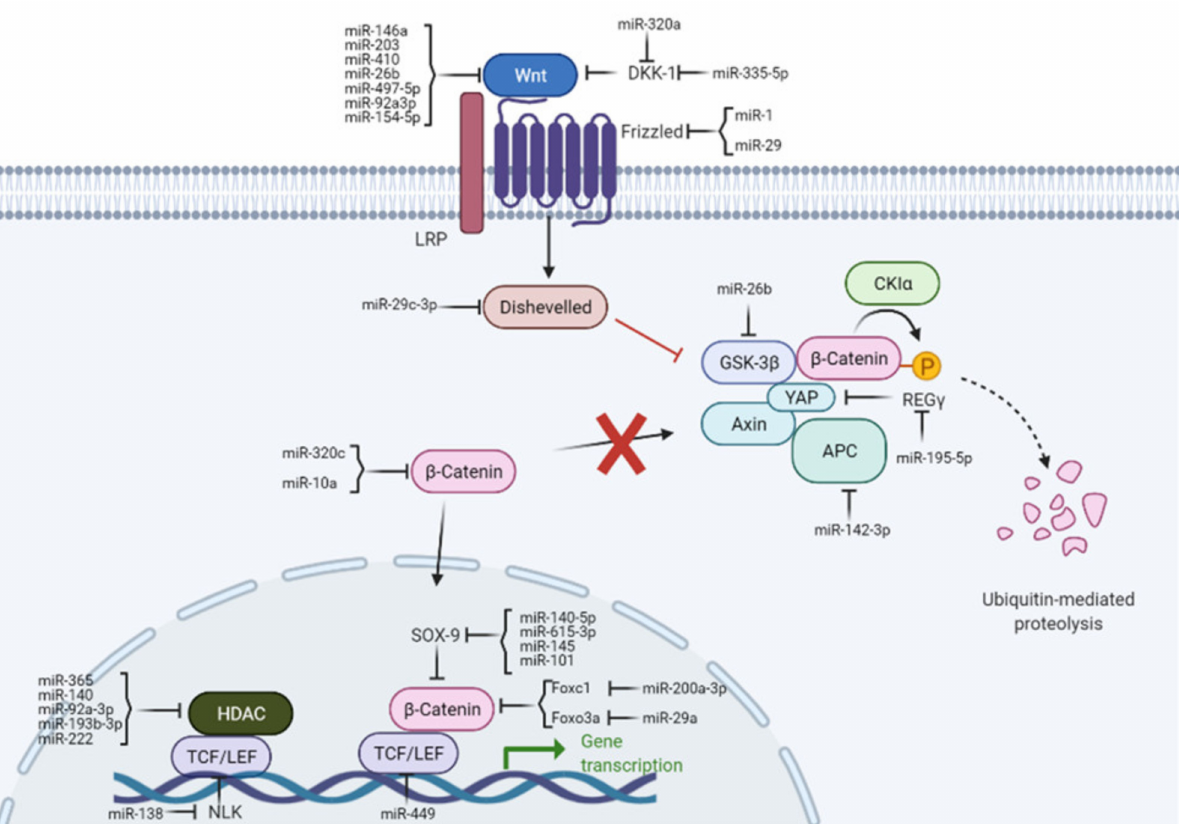
Figure 2. Regulatory functions of miRNAs on canonical Wnt signaling pathways in OA. miRNAs influence various steps of the Wnt pathway by targeting Wnt ligands (i.e., DKK1), receptors (i.e., Wnt), β -catenin, or Wnt transcription factors (i.e.,